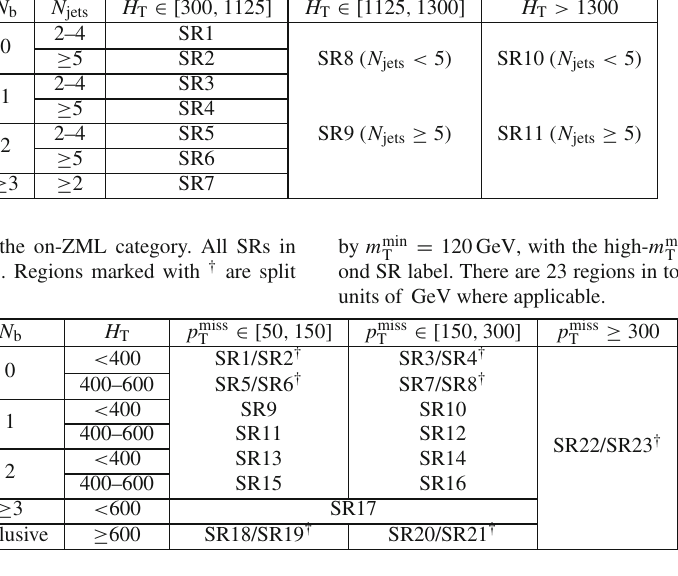
= 120GeV, with the high- m min m min region specified by the second T T SR label. There are 21 regions in total. Quantities are specified in units of GeV where